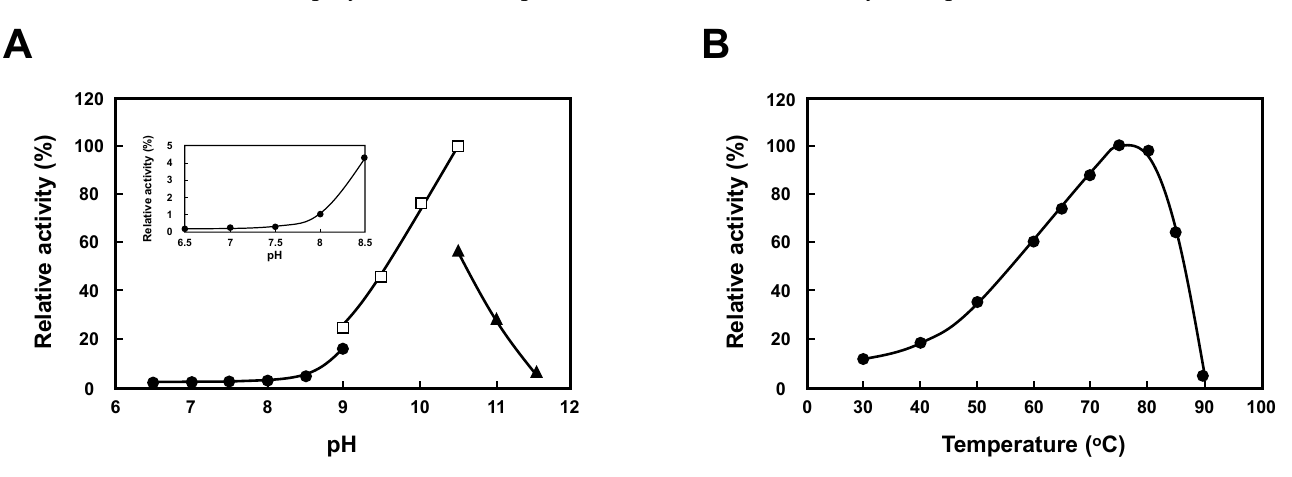
Figure 5. pH and temperature dependency of the enzymatic activity. The reactions were measured as described in Materials and Methods. ( A ) pH dependency. Buffers used were Tris-HCl (pH 6.5–9), glycine-NaOH (pH 9–10.5), and CAPS-NaOH (pH 10.5–11.5). Reactions were performed for 1 h at 75 °C. ( B ) Temperature dependency. The reaction was performed in Tris-HCl (pH 8.5) for 1 h at 75 °C.